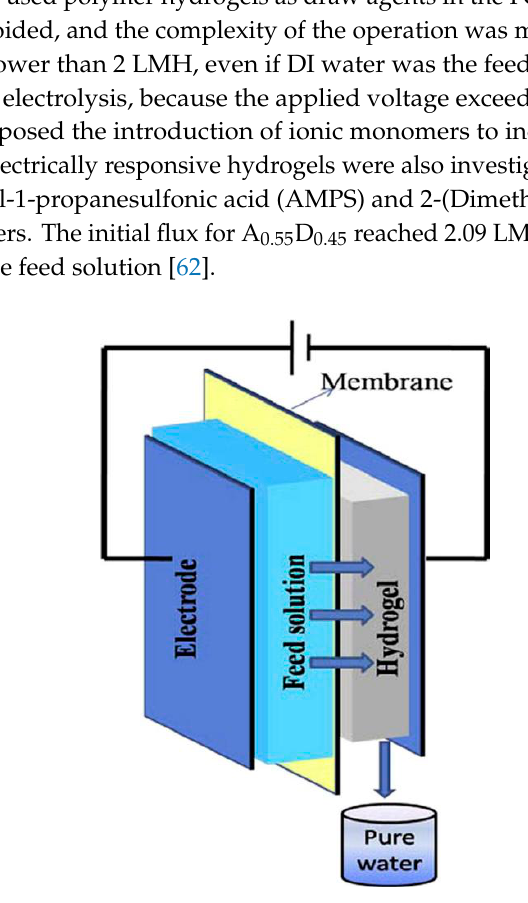
Figure 7. Schematic representation of the forward osmosis (FO) desalination process considering hyaluronic acid-poly(vinyl alcohol) (HA-PVA) polymer hydrogels as the draw agents. Reprinted from Reference [60] with permission from Elsevier.